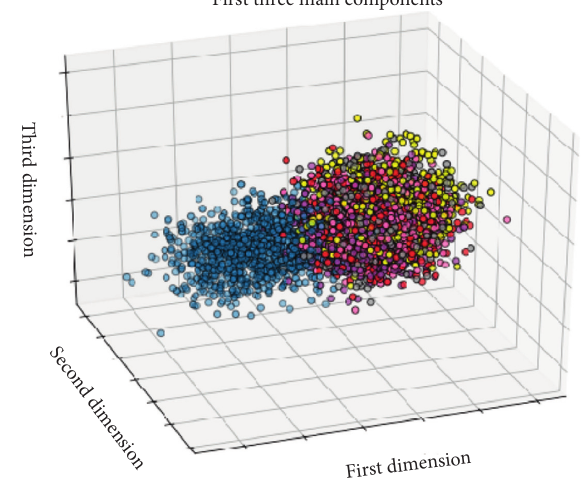
Figure 5: 3D scatter plot of original data.